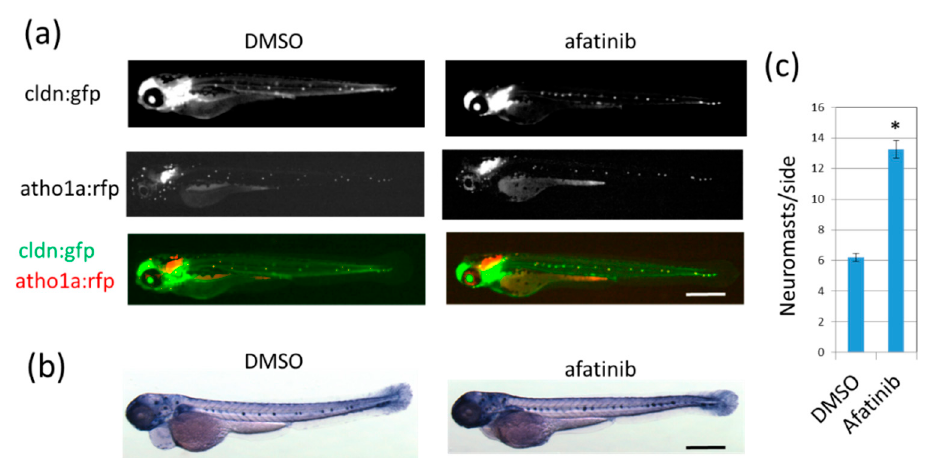
Figure 1. Afatinib induces the development of extra lateral line neuromasts in zebrafish larvae. ( a and b ) Neuromasts of 72 hpf larvae treated with DMSO (left) or afatinib (right) from 26 hpf were detected by fluorescence from cldn : gfp ; atoh1 : rfp transgenic larvae (a) or by endogenous ALP activity (b). (a) Fluorescence from cldnb:gfp highlighted neuromast cells and the epidermis, and fluorescence from atoh1a:rfp highlighted neuromast hair cells. GFP and RFP images were merged. Compared to DMSO treatment, increased neuromasts were observed in afatinib-treated zebrafish larvae. Scale bar = 500 µ m. (c) The number of neuromasts on one side were counted. The graph indicates mean ± SEM ( n = at least 54). *p < 0.01; hpf, hours postfertilization; DMSO, dimethyl sulfoxide; ALP, alkaline phosphatase; GFP, green fluorescent protein; RFP, red fluorescent protein; SEM, standard error of the mean.